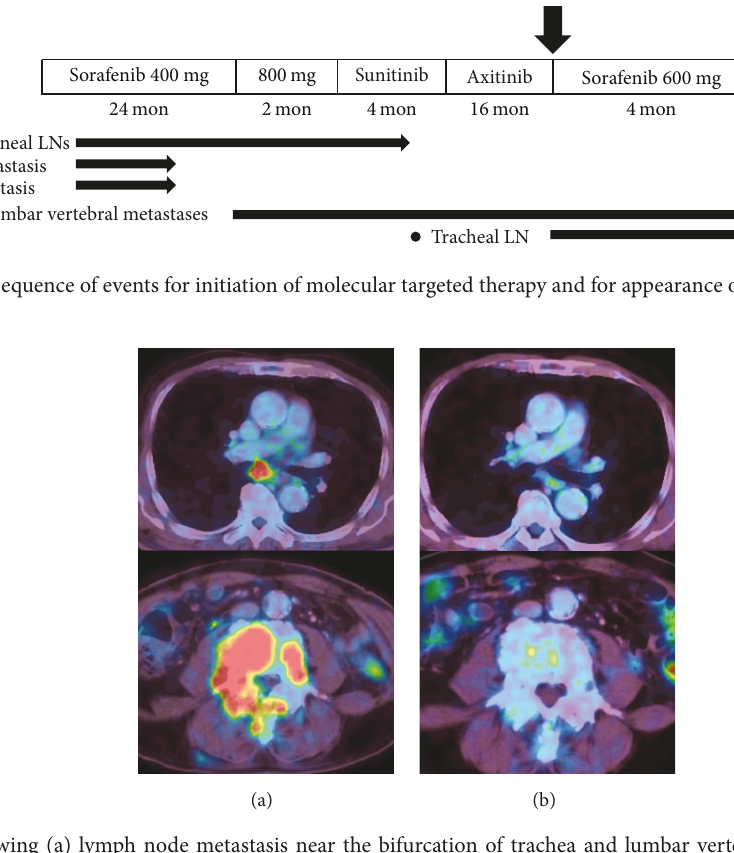
Figure 2: PET-CT showing (a) lymph node metastasis near the bifurcation of trachea and lumbar vertebral metastasis before sorafenib rechallenge therapy and (b) that the metastatic lesion vanished 5 months after the rechallenge